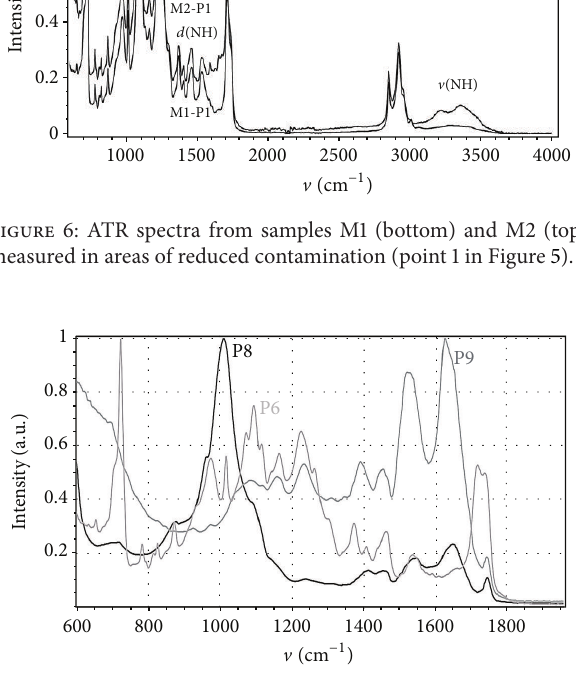
Figure 7: ATR spectra taken on sample M1 at positions where remains of adhered salmon were observed. Points 6, 8, and 9 from Figure 5.